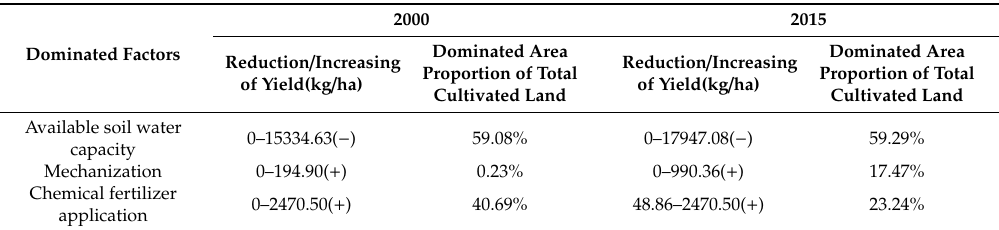
Table 4. The reduction or increasing e ff ect of grain crop yield and the area proportion of dominated factors in 2000 and